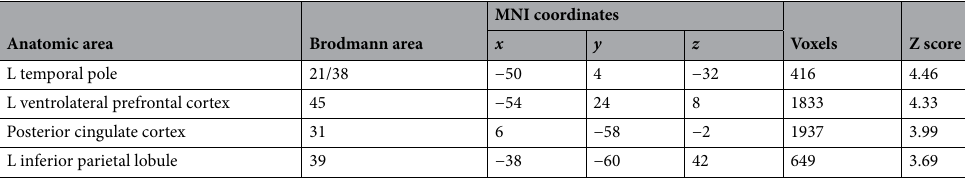
Table 2. Brain areas showing decrease of activation when semantic distance decreased. Activations shown for whole brain analysis. All clusters are significant at p < .05 after statistical correction for multiple comparisons (FDR correction).